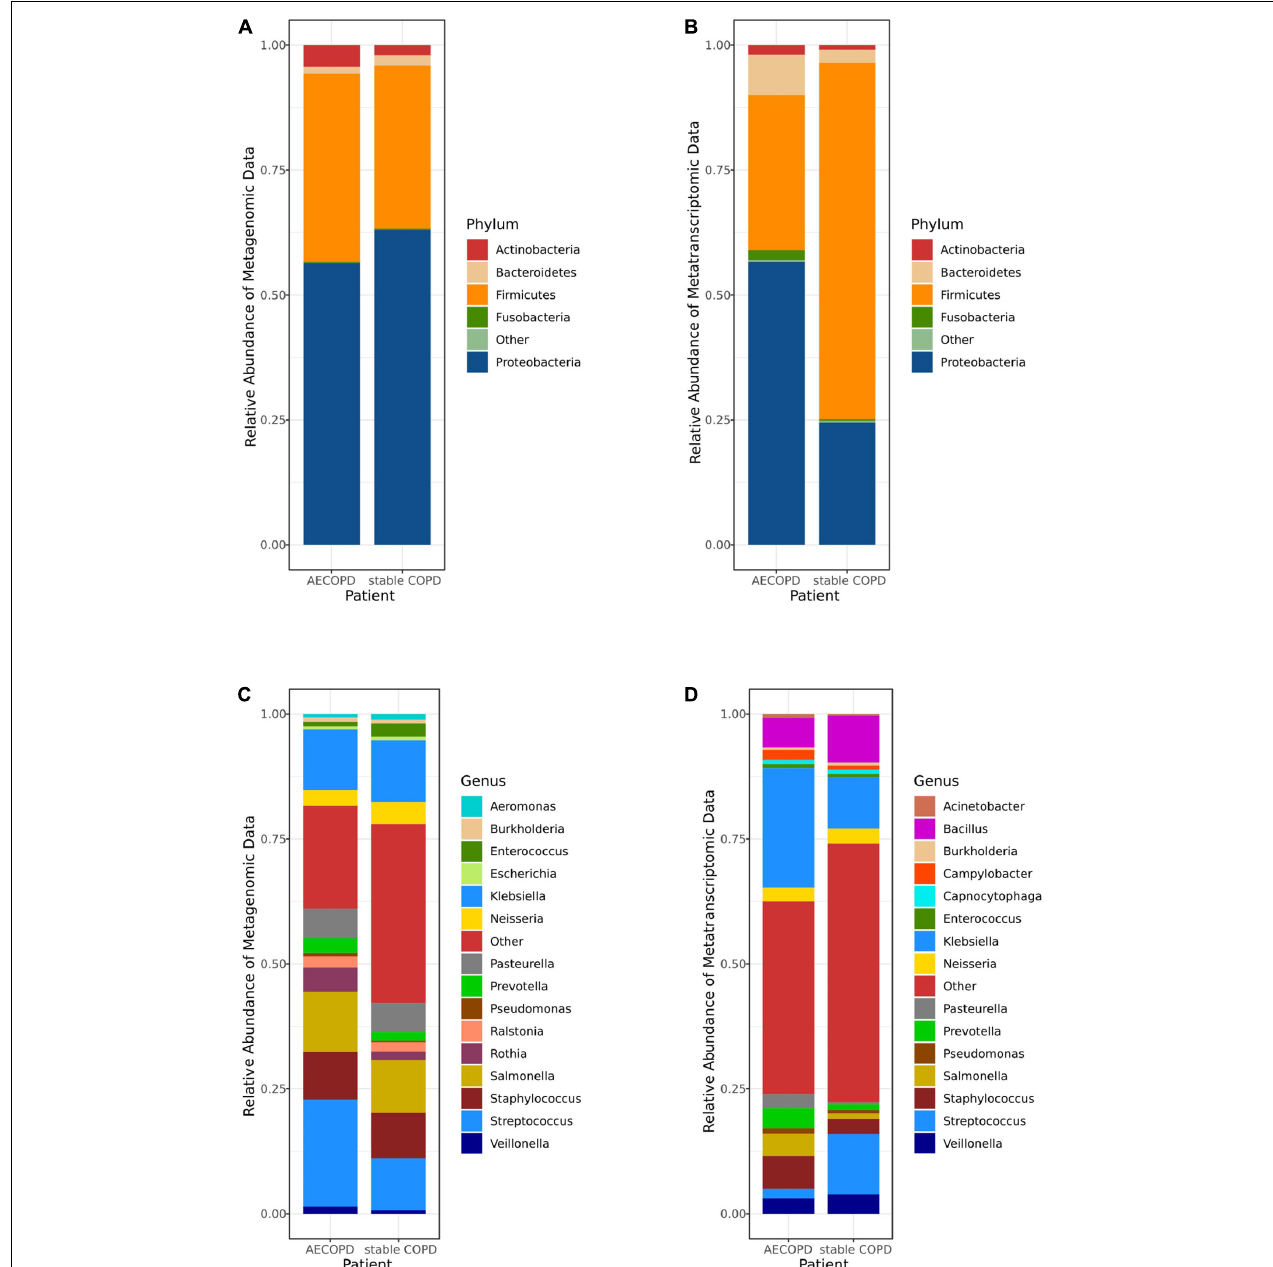
FIGURE 1 | The microbiomes compositional profiles of the Acute Exacerbation of Chronic Obstructive Pulmonary Disease (AECOPD) patients and stable COPD (stabilization of AECOPD patients after treatment) patients. The stacked bar represents differentially relative abundance of microorganisms in the AECOPD vs. stable COPD groups. (A,B) shows the relative abundance of the most dominant taxa at the phylum levels in metagenomic data (A) and metatranscriptomic data (B) . (C,D) shows the most dominant taxa distributions at the genus levels of the sputum microbiomes in metagenomic data (C) and metatranscriptomic data (D)